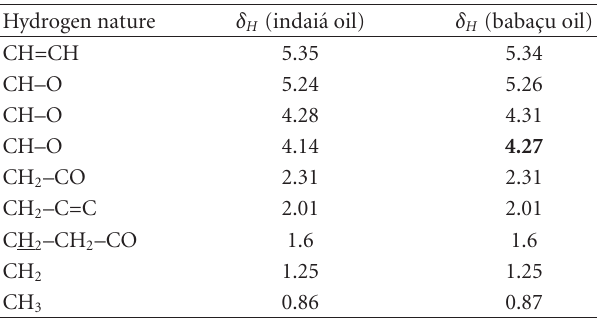
Table 2: 1 H NMR data of indai´a and babassu oils in CDCl 3